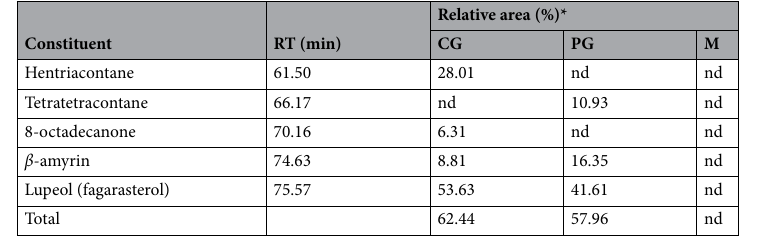
Table 3. Composition of triterpenes identified in epicuticular wax of Laguncularia racemosa leaves. *Mean amount of wax extracted with chloroform. RT—Retention time obtained by GC. nd Not detected. CG Coroa Grande; PG Pedra de Guaratiba, and M